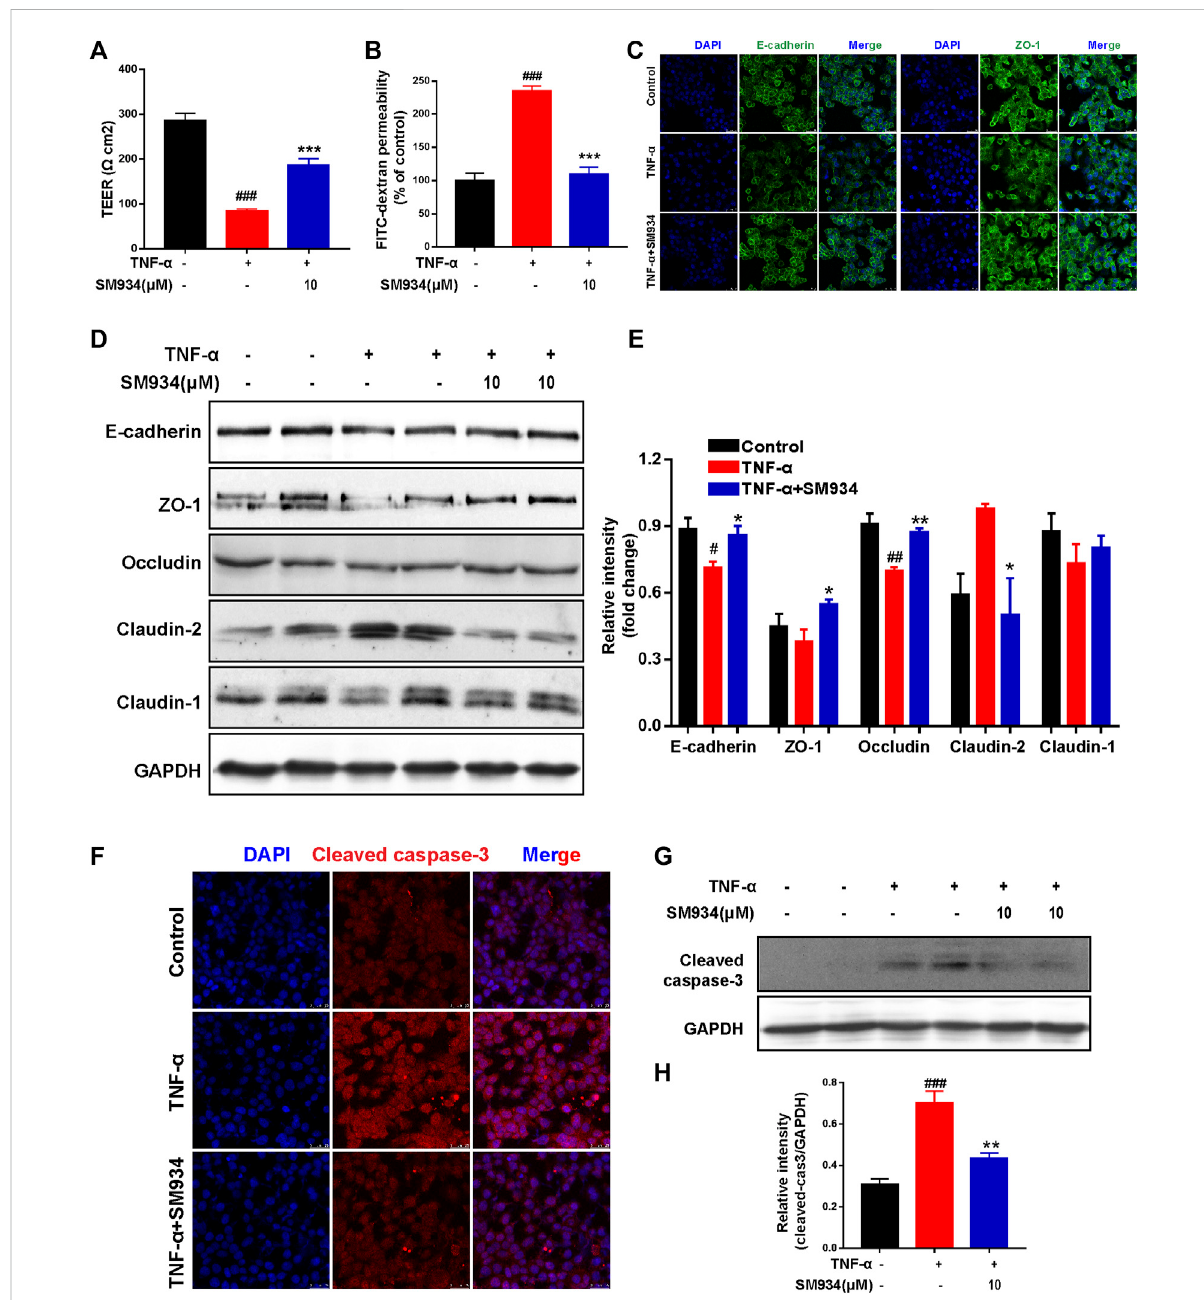
SM934 protected the epithelial barrier function of IECs by regulating the aberrant expression of TJ proteins and apoptosis. Caco-2 cells were treated with or without TNF- α (100 ng/ml) in the absence or presence of SM934 (10 μ M) for 24 h (A) Transepithelial electrical resistance (TEER) and (B) permeability of FITC-dextran of Caco-2 cell monolayers were detected. HT-29 cells were pre-incubated with SM934 (10 μ M) for 1 h and then exposed to hTNF- α (100 ng/ml) in the presence or absence of SM934 for 24 and 72 h and then using for immuno fl uorescence and Western blotting assays, respectively. (A) Representative fl uorescence images of E-cadherin and ZO-1 stimulated by TNF- α for 24 h in HT-29 cells and measured with a confocal laser-scanning microscope (scale bars, 25 µm). (B) Western blotting assayed the TJ protein expressions of E-cadherin, ZO-1, occludin, claudin-2, and claudin-1 and were treated with TNF- α for 72 h in HT-29 cells. (C) Relative intensity of proteins to GAPDH. (D,E) HT- 29 cells were treated with TNF- α in the presence or absence of SM934 in HT-29 cells for 24 h to measure the expression of cleaved caspase-3 by immuno fl uorescencestaining(Scalebars,25 µm)andWesternblotassay. (E) RelativeintensityofproteintoGAPDH.Dataareshownasmeans±SEM fromthreerepresentativeexperiments. (F) Theexpressionofcleaved-caspase3inHT-29cellswasdetectedbyImmuno fl uorescencestaining(Scare bars, 25 μ m). (G) The protein level of cleaved caspase-3 in HT-29 cells was detected by westernblot. (H) The relative intensity of cleaved-caspase-3 to GAPDH. # p < 0.05 and ## p < 0.01 vs . control group; * p < 0.05 vs . TNF- α